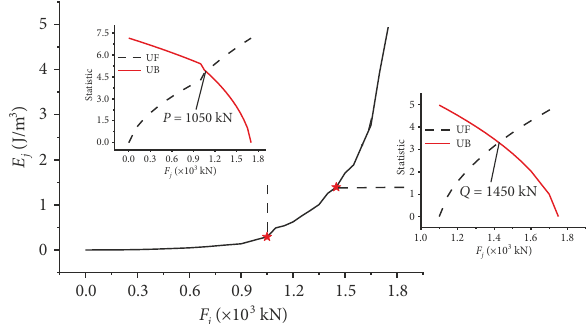
Figure 6. The E j - F j and M-K statistic